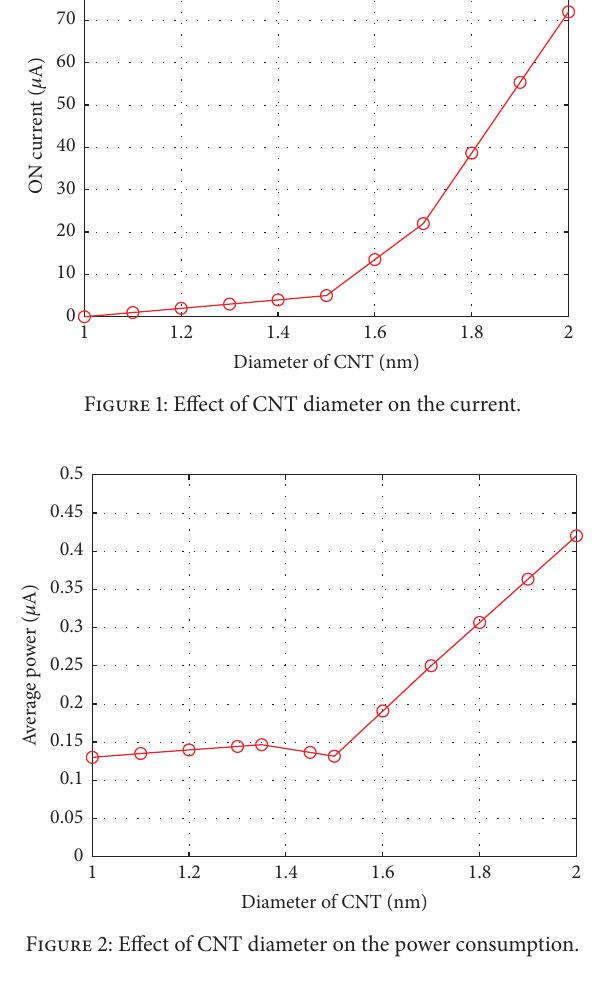
Figure 4: Effect of CNT number on the ON